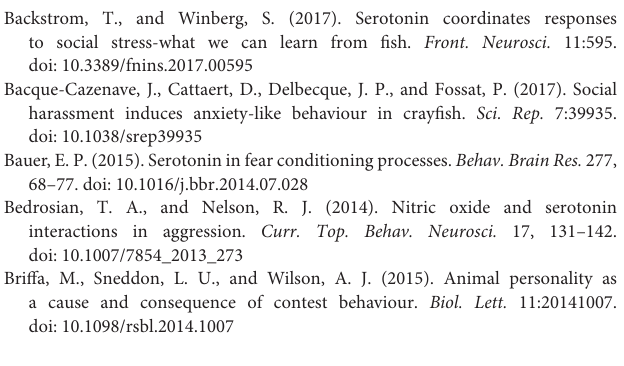
Figure S1 | Dose dependent effects of fluoxetine (A) and 5HTP (B) . Plots of level of aggression exhibited by crickets at their first fight against hyper-aggressive opponents and 3h after defeat (symbols: median, bars interquartile range, n > 16 for each). Figure S2 | Ketanserin blocks effect of fluoxetine. (A) Procedure: Test cricket received vehicle or drug 1h before their first fight against hyper-aggressive opponents, which they lost, and once more 1h after defeat. (B) Level of aggression, (C) Fight duration. Significant differences are given as p -values from Kruskal-Wallis tests, and differences between groups from Dunn’s multiple comparisons are indicated by asterisks: ∗∗ p < 0.01, n.s. not significant. Note that fluoxetine no longer prohibits post-defeat recovery (red bars) when given together with the 5HT receptor blocker ketanserin (red-hatched